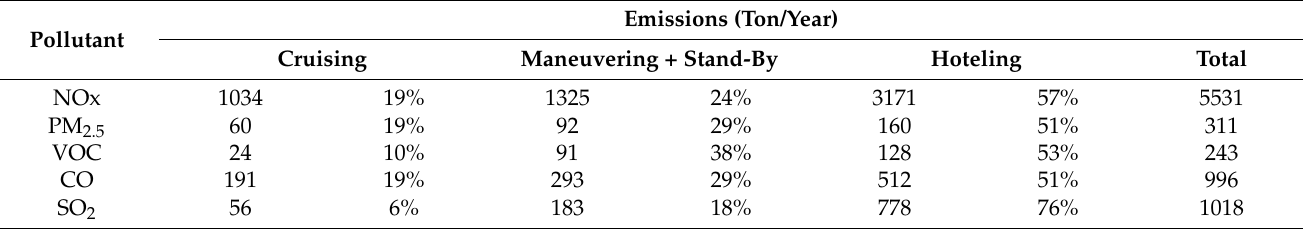
Table A20. Total emissions from vessels (Ashdod, MPS A1